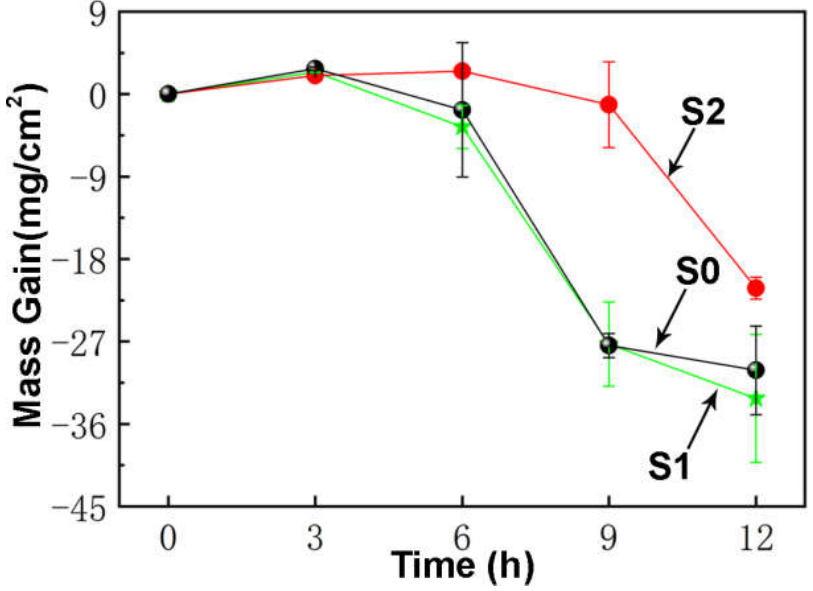
Figure 4. Corrosion kinetics of sprayed and annealed coatings.